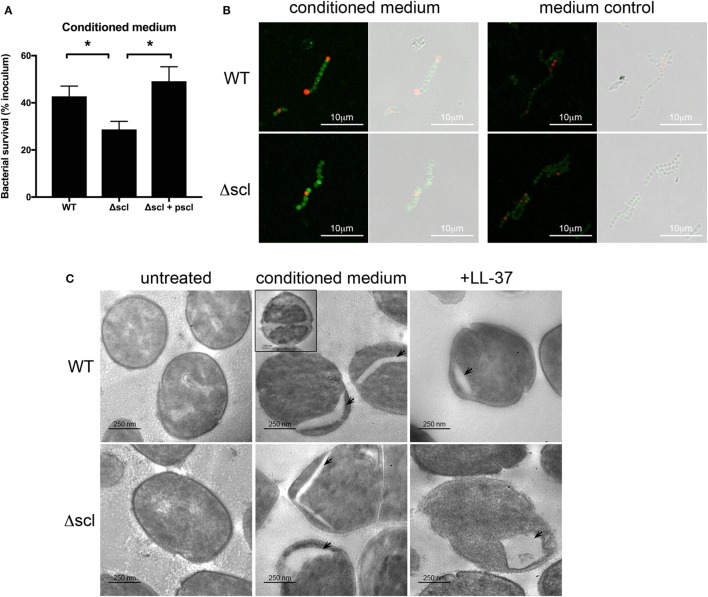
LL-37 in mast cell granules is a potent anti-group A Streptococcus effector. (A) Survival of WT, Δscl, and Δscl plasmid-complemented (Δscl + pscl) strains with HMC-1 conditioned medium. Data from at least three independent experiments were combined, results are given in average ± SEM and analyzed by one-way ANOVA with Sidak’s multiple post-test (**P < 0.01, *P < 0.05). (B) Merged immunofluorescence and corresponding phase contrast images of WT and Δscl strains incubated with or without HMC-1 conditioned medium. LL-37 is indicated in green, propidium iodide in red. Images taken at 63× magnification with 2.5× digital zoom. (C) Transmission electron microscopy images of WT and Δscl strains incubated with media (untreated), HMC-1 conditioned medium or LL-37 peptide. Arrows indicate empty cytoplasmic areas. Inset: bacterial cell with intact membrane and less electron-dense cytoplasm (ghost). Images taken at 20,000× magnification.